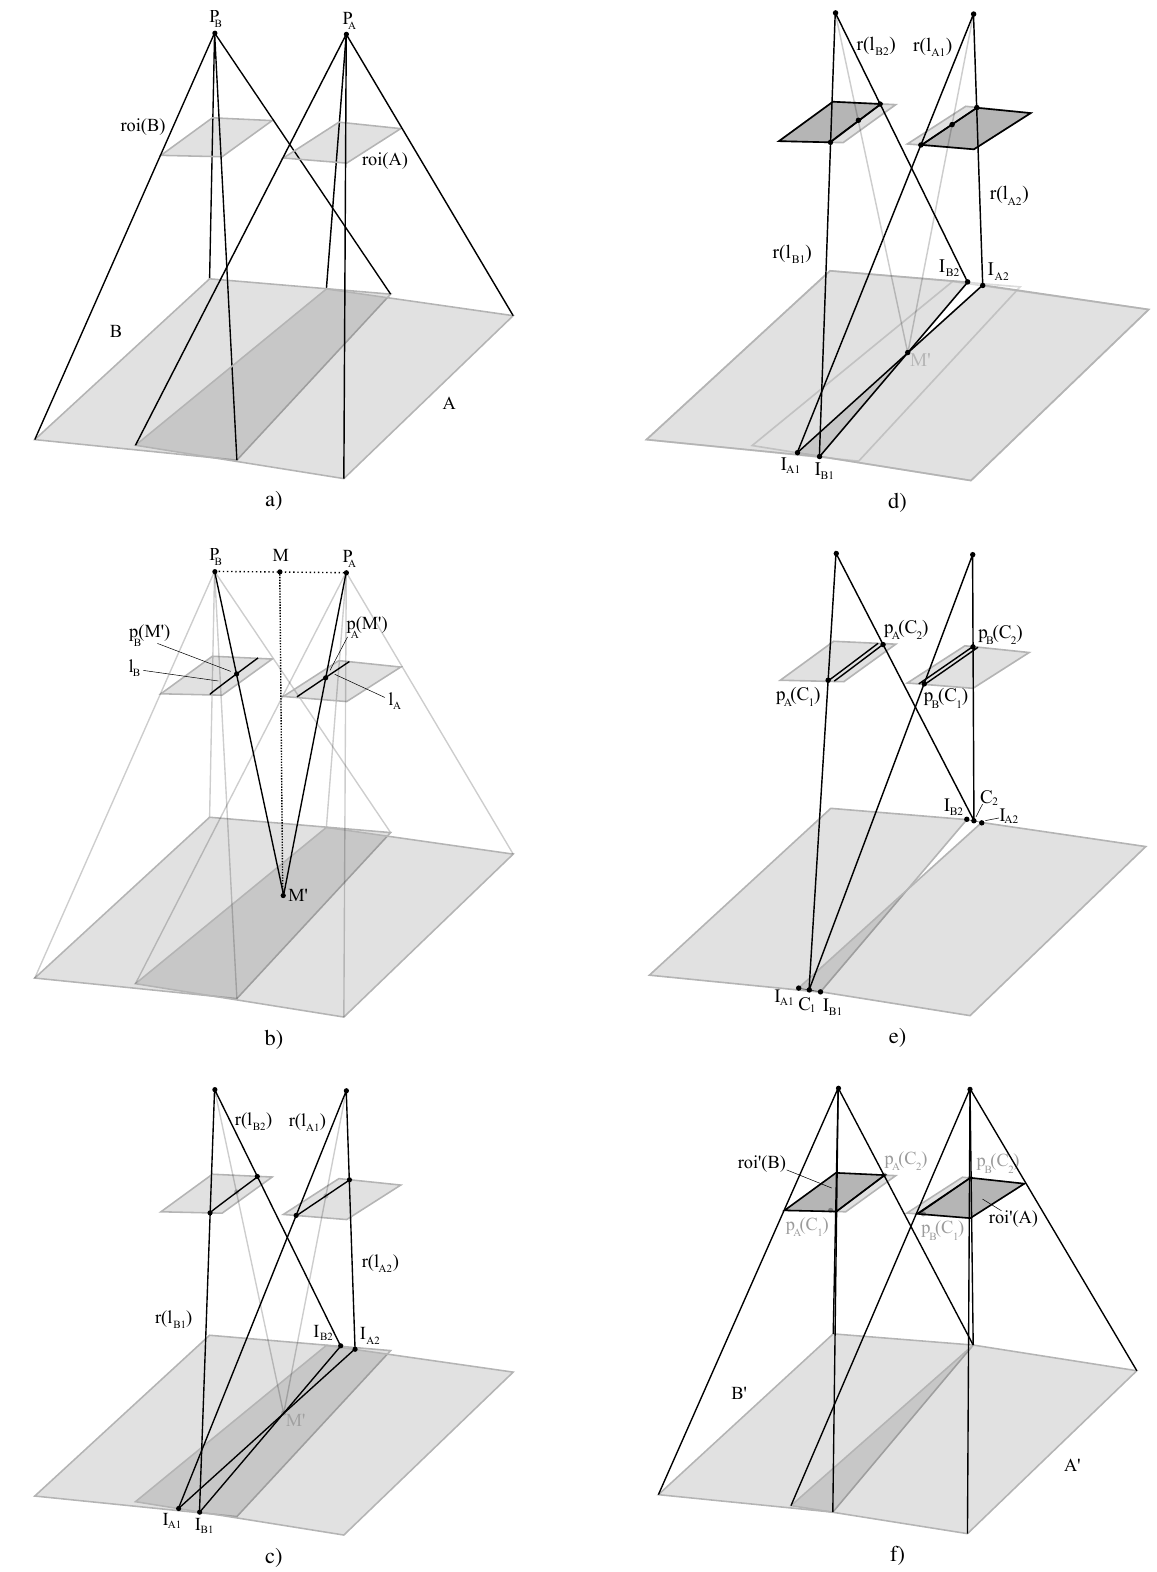
Figure 1. Terrain aware image clipping (TAC) algorithm: a) Full frame projection of two overlapping aerial images. b) Projection M (cid:48) of centre M between both cameras and reprojection of M (cid:48) into both sensors ( p A ( M (cid:48) ) and p B ( M (cid:48) ) ) and corre- sponding sensor lines l A and l B . c) Projection of sensor line endings to the ground I A 1 , I A 2 , I B 1 and I B 2 . d) Cropping of aerial images by application of l A and l B and their projections. e) Determination of centres C 1 and C 2 between line endings of projection of l A and l B and reprojection of C 1 and C 2 into sensors p A ( C 1 ) , p A ( C 2 ) , p B ( C 1 ) and p B ( C 2 ) . f) Final clipping roi (cid:48) ( A ) and roi (cid:48) ( B ) by application of these reprojection points and their